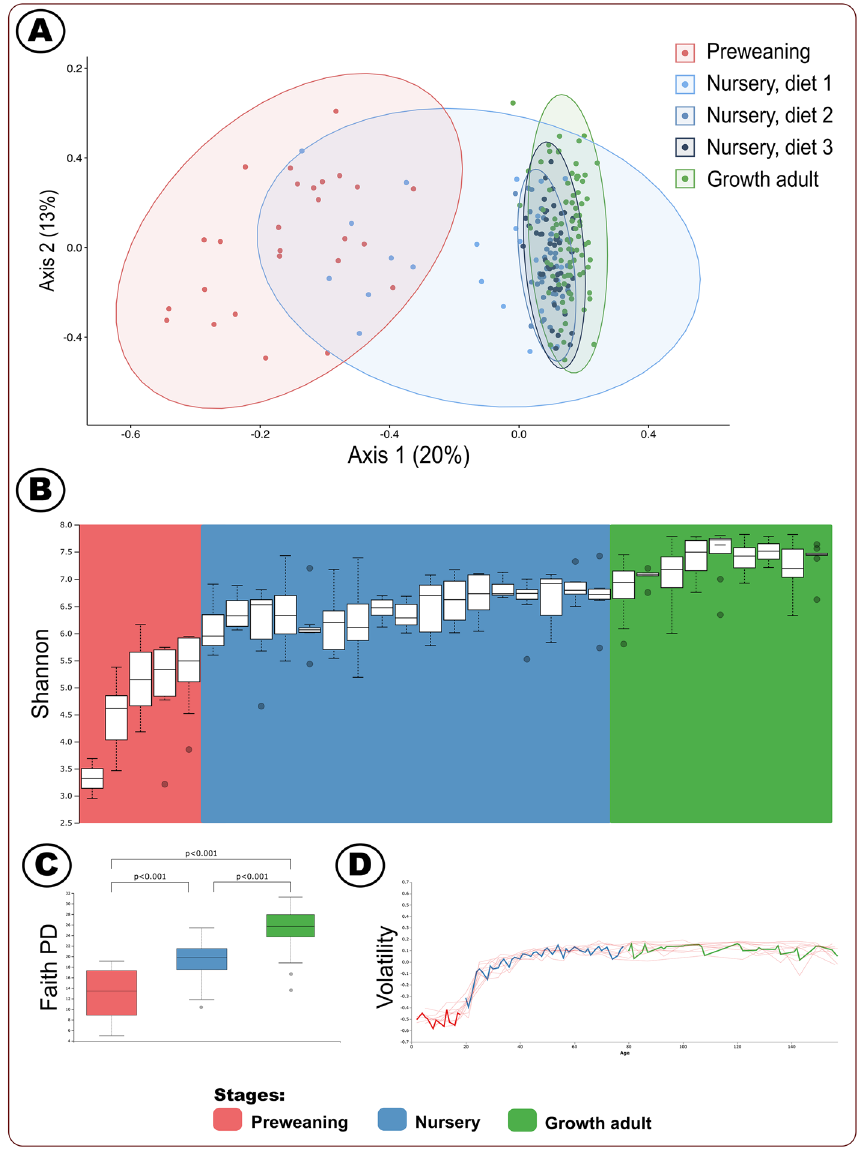
Figure 1. ( A ) Weighted uniFrac PCoA plot 29–32 depicting composition; dots represent distinct samples. Nursery stage is separated according to the three diets fed during the stage. ( B ) Longitudinal Shannon diversity with Kruskal–Wallis statistical analysis 30 . ( C ) Faith’s phylogenetic diversity 30 (PD). ( D ) Volatility control chart of the first axis of the PCoA 30 . Figure was edited in Inkscape version 1.0.2 (https:// inksc ape. org/) 88